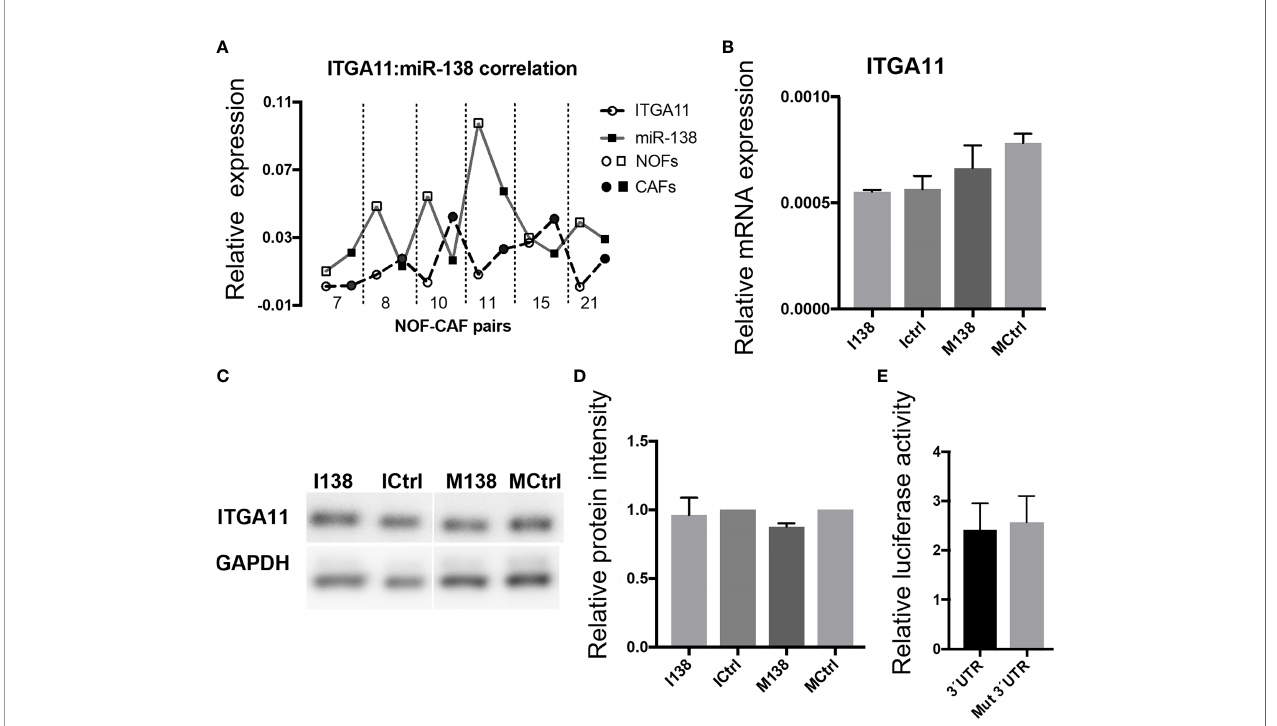
FIGURE 4 | miR-138 does not target ITGA11. (A) Graph showing an inverse correlation between miR-138 and ITGA11 levels in the fi broblasts. (B) Modulation of miR-138 expression did not result in alterations of ITGA11 expression at mRNA or (C, D) protein levels in CAF. (E) ; Gene reporter assay showing no difference in the expression of ITGA11 or mutant